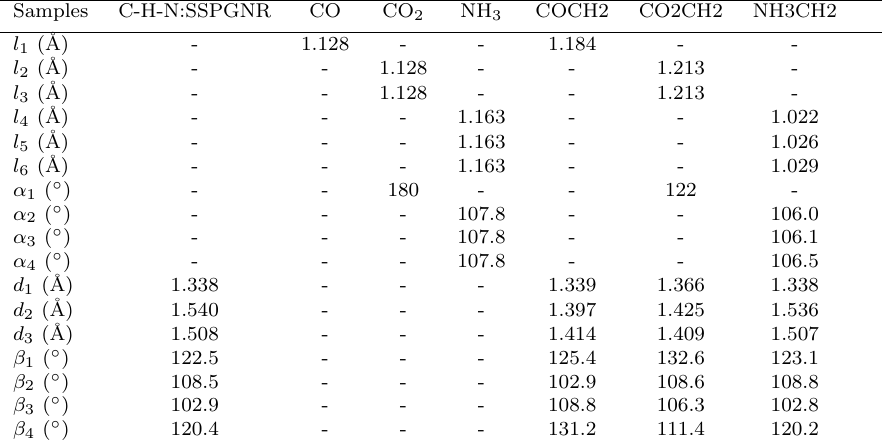
Table 3: Bond lengths of gas molecules before and after adsorption ( l 1 to l 6 ), bond angles of gas molecules before and after adsorption ( α 1 to α 4 ), bond lengths at edge of C-H-N:SSPGNR before and after gas molecule adsorption ( d 1 to d 4 ), and bond angles of C-H-N:SSPGNR before and after adsorption for gas molecules ( β 1 to β 4 ).